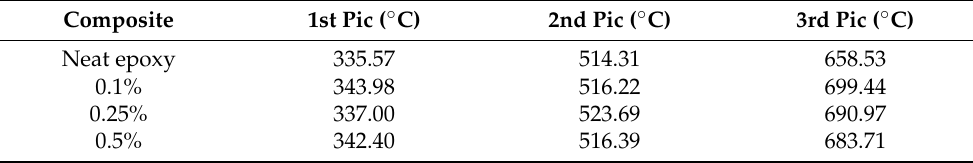
Table 3. Temperature pics of the TGA derivative for epoxy-ZnO composites after irradiation.